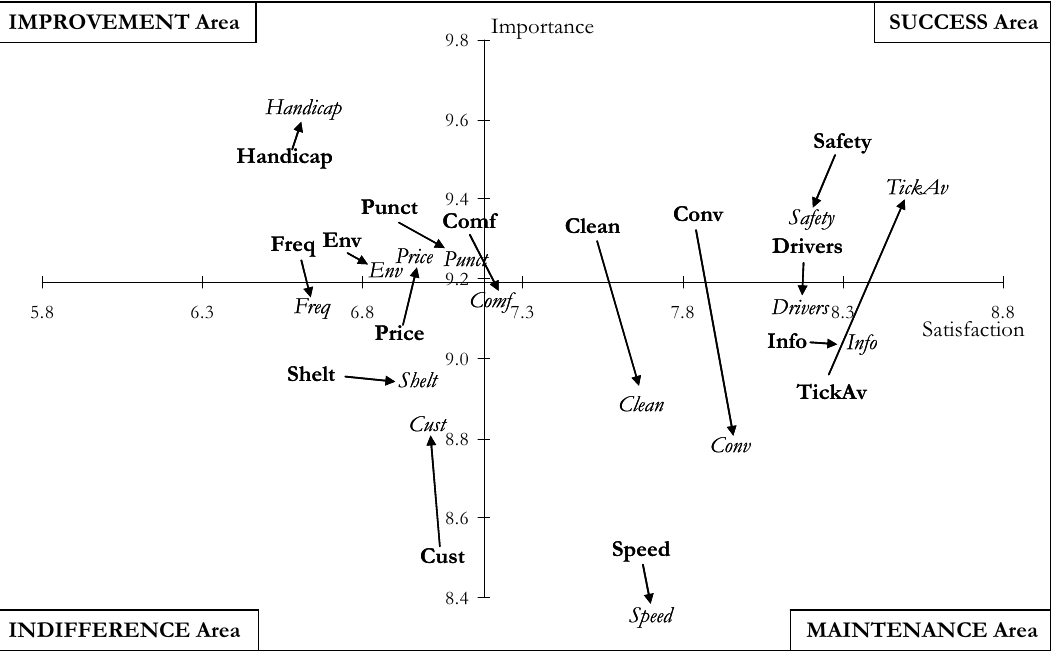
Figure 3 – The IMPACT MATRIX in 2002 (bold) and 2004